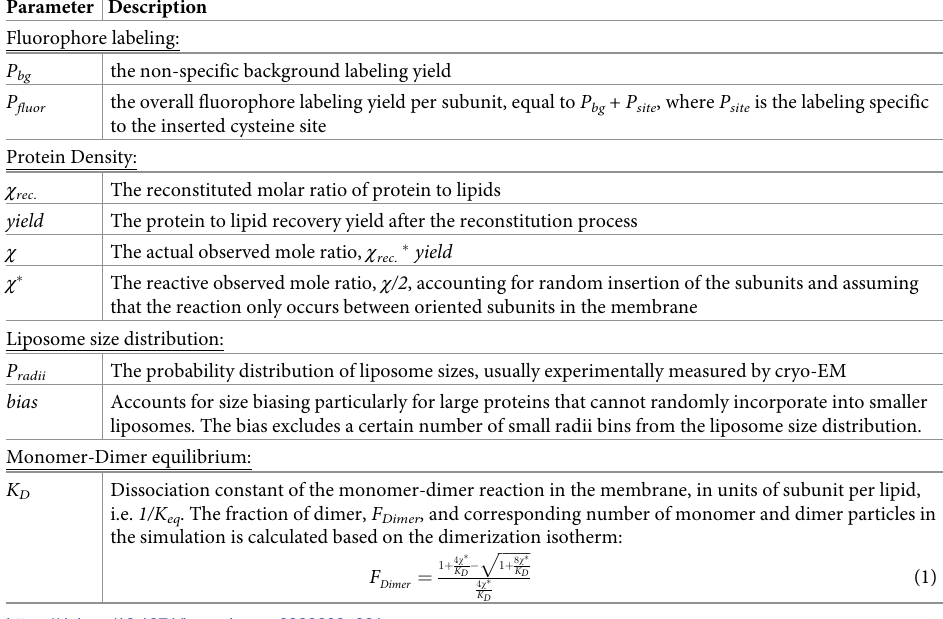
Table 1. Description of modeling parameters for protein reconstitution in